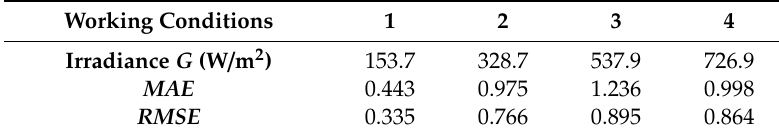
Table 3. RMSE and MAE of I–V curve obtained by equivalent circuit method.